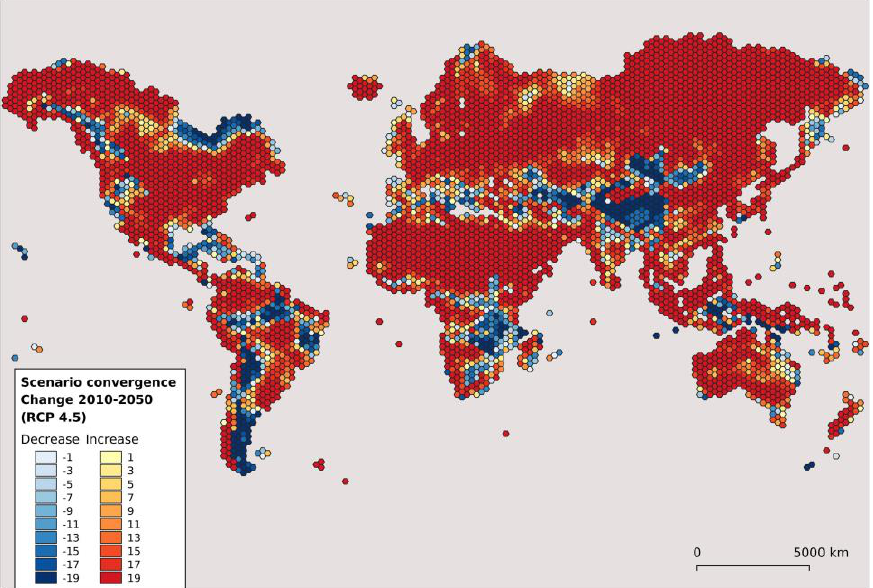
Figure 5. Scenario convergence aggregated a pixel of 250 km 2 . Each scenario counts as +1 (increase) or − 1 (decrease). Each pixel represents the sum of the increased/decreased scenarios [56].